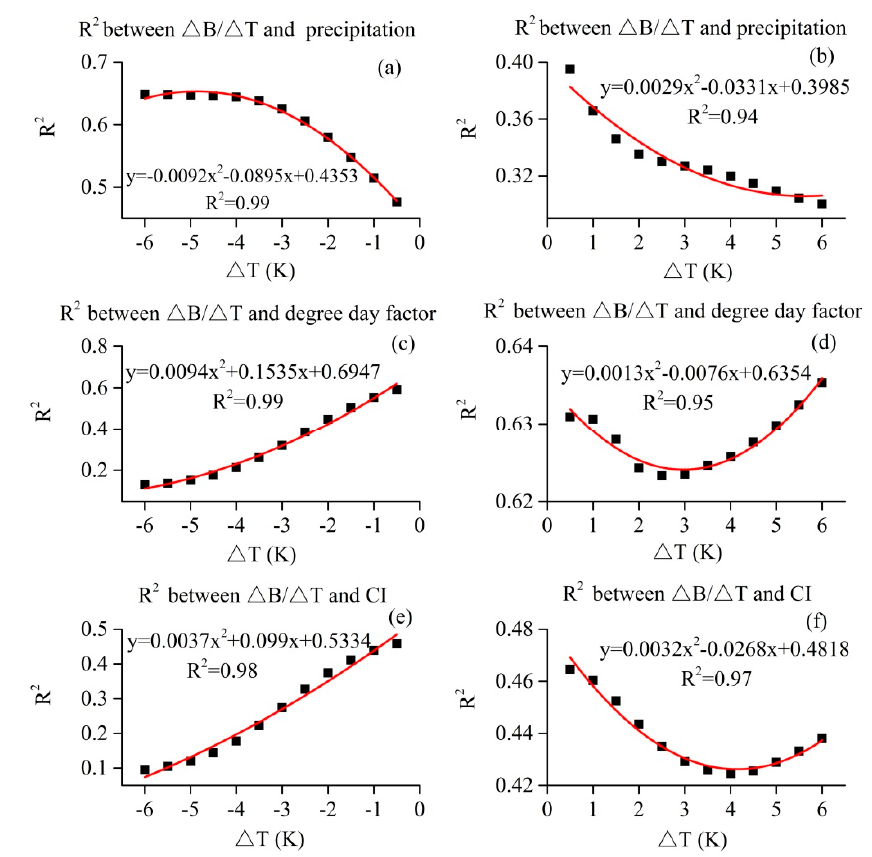
Figure 8. Squared correlation coefficient (R 2 ) between the mass balance sensitivity and ( a , b ) annual precipitation, ( c , d ) degree day factor, and ( e , f ) CI, all calculated across the 45 glaciers and shown for a range of temperature change, Δ T , scenarios.